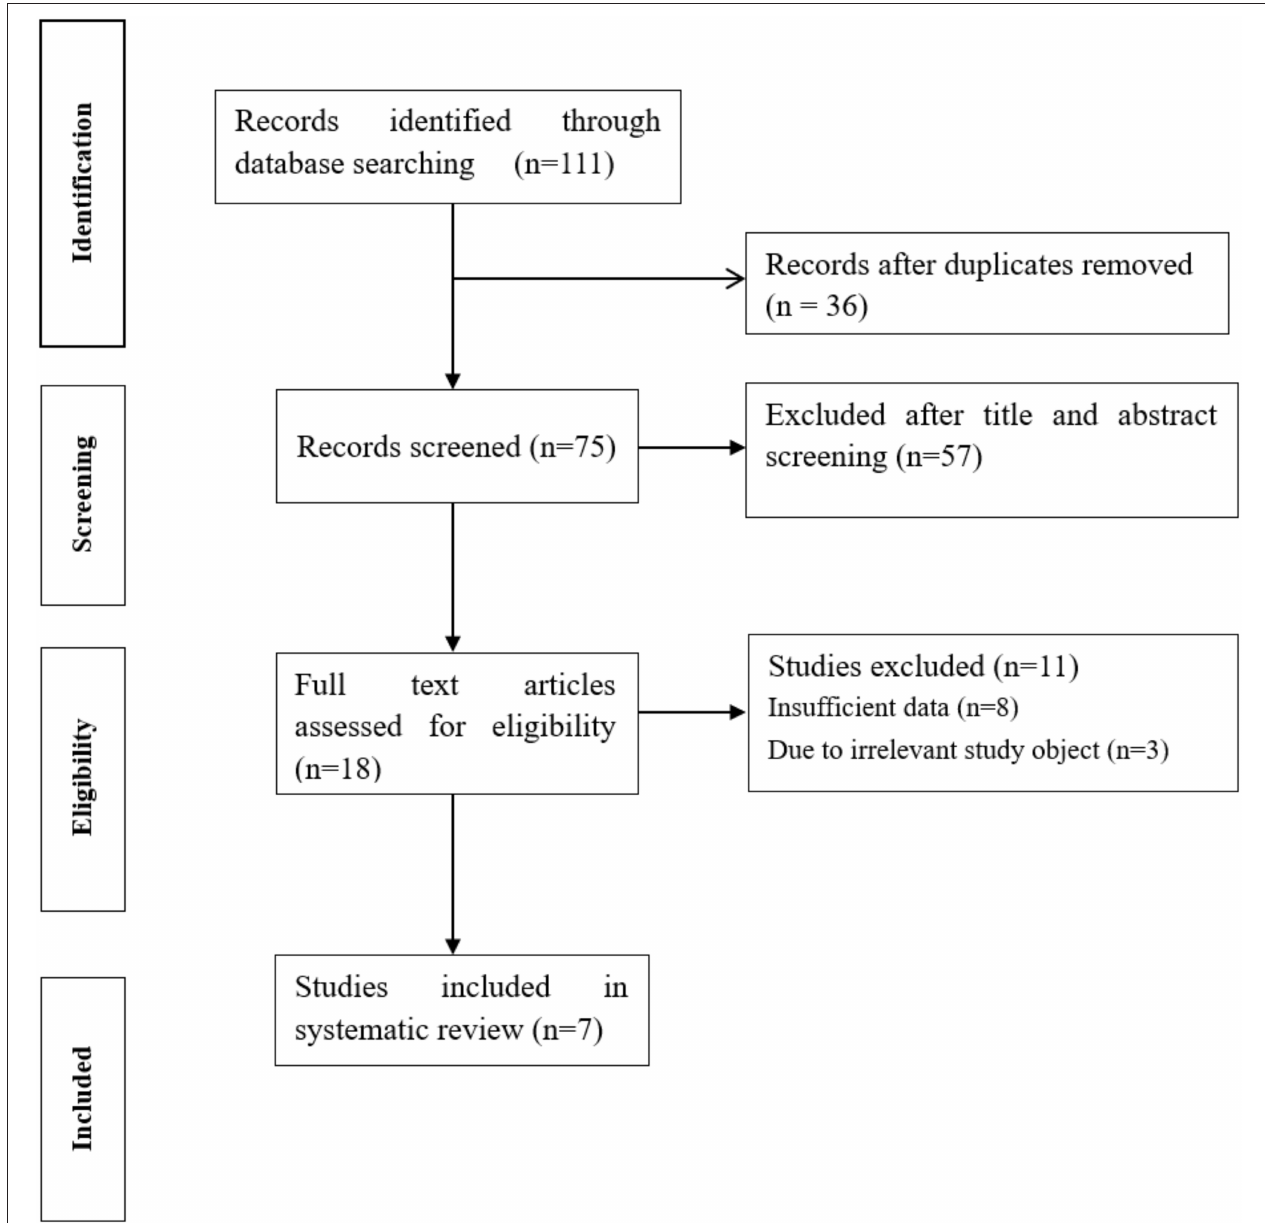
FIGURE 1 | Flow chart of the study selection